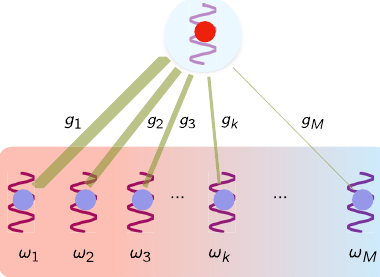
FIG. 3. Schematic model of a damped harmonic oscillator. See the text for